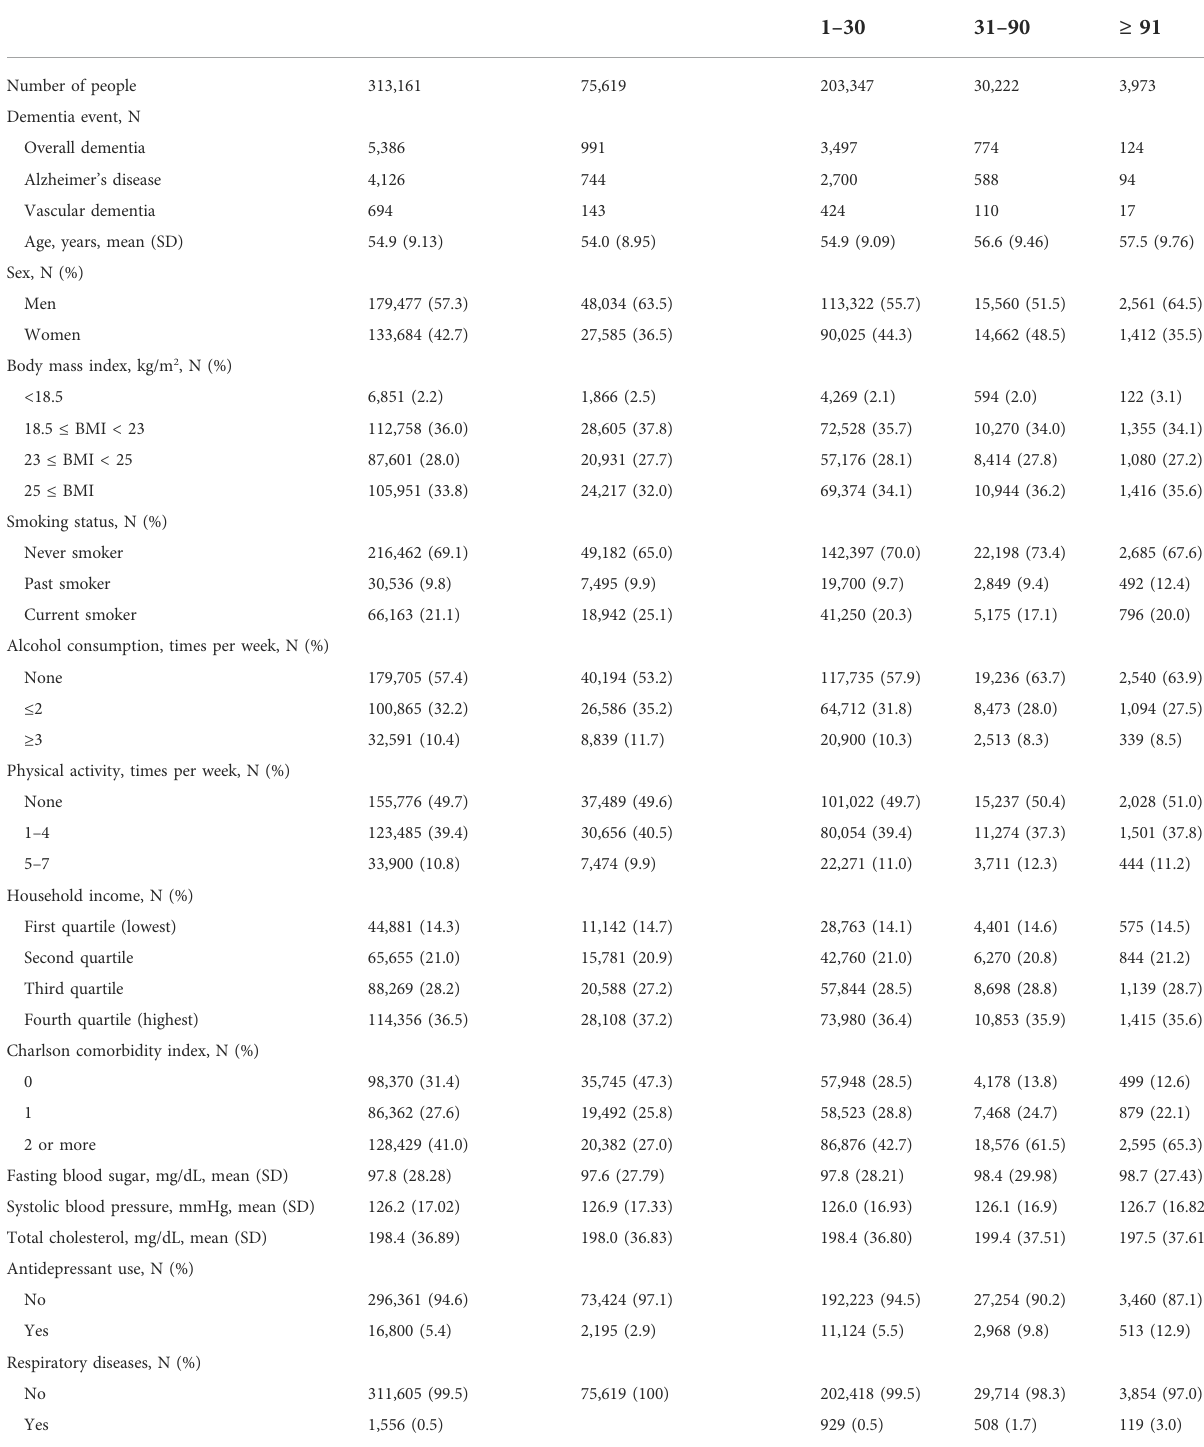
TABLE 1 Descriptive characteristics of the cohort study